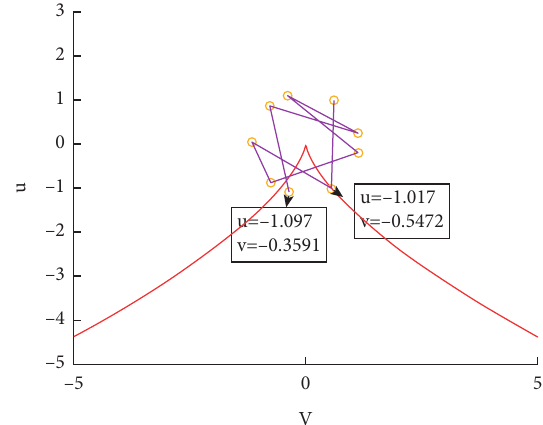
Figure 5: Plane projection chart of Shanghai crude oil futures price sudden change in